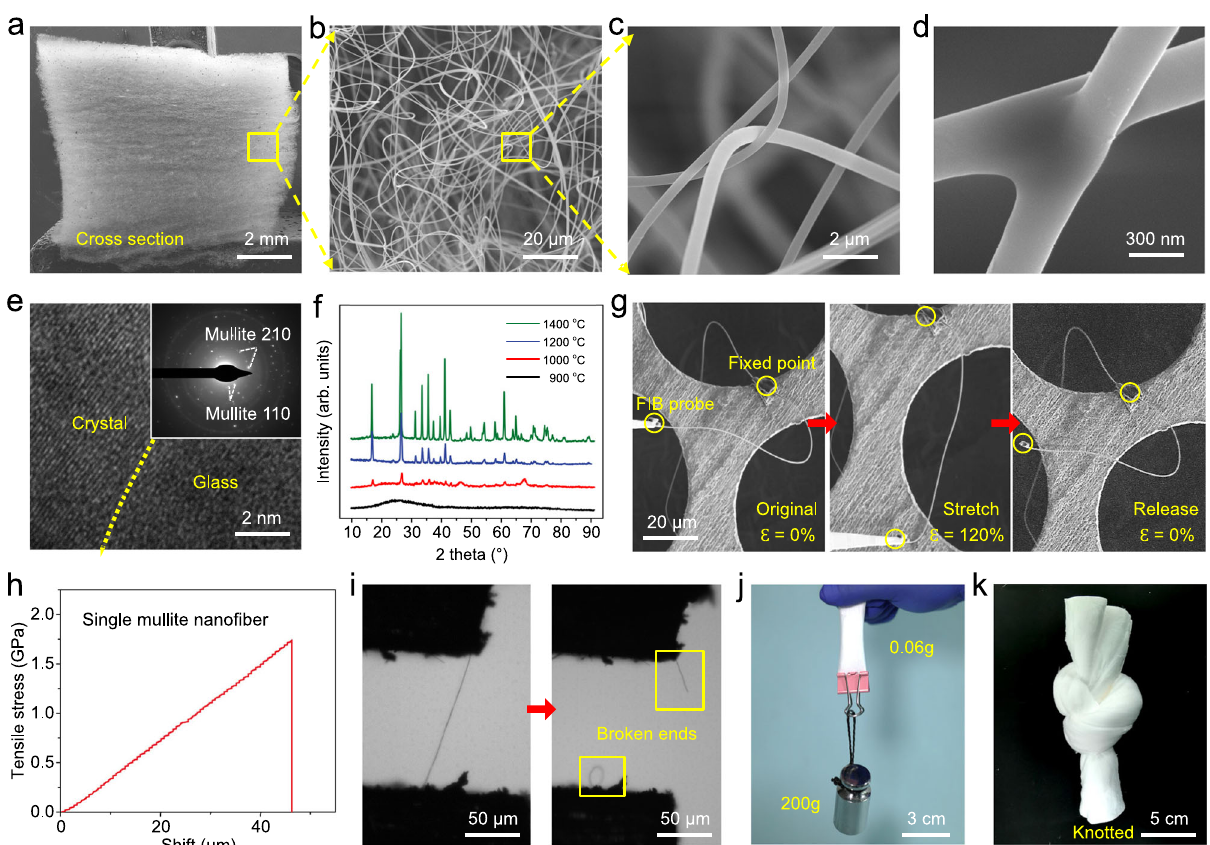
Fig. 2 Material characterization of ICCAs. a , b SEM image of ICCAs at different magni fi cations in the cross section showing a knitted crimped-nano fi bre structure with abundant entanglements. c , d SEM image of the interknitted structure and a crosslinking point between nano fi bres. e Transmission electron microscopy (TEM) and high-angle annular dark- fi eld STEM (HAADF-STEM) images of a mullite nano fi bre. f XRD spectra of the mullite fi bres. g Crimped nano fi bre stretched from its original structure up to 120% strain without fracture. h Tensile stress-strain curves of a single ceramic nano fi bre. i Images of the fi bre before and after tensile fracture. j , k The ICCAs can be stretched and knotted without